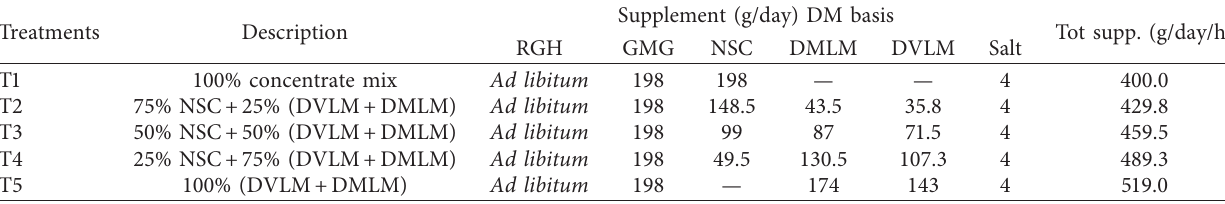
Table 1: Proportion of different feed ingredients to formulate the experimental